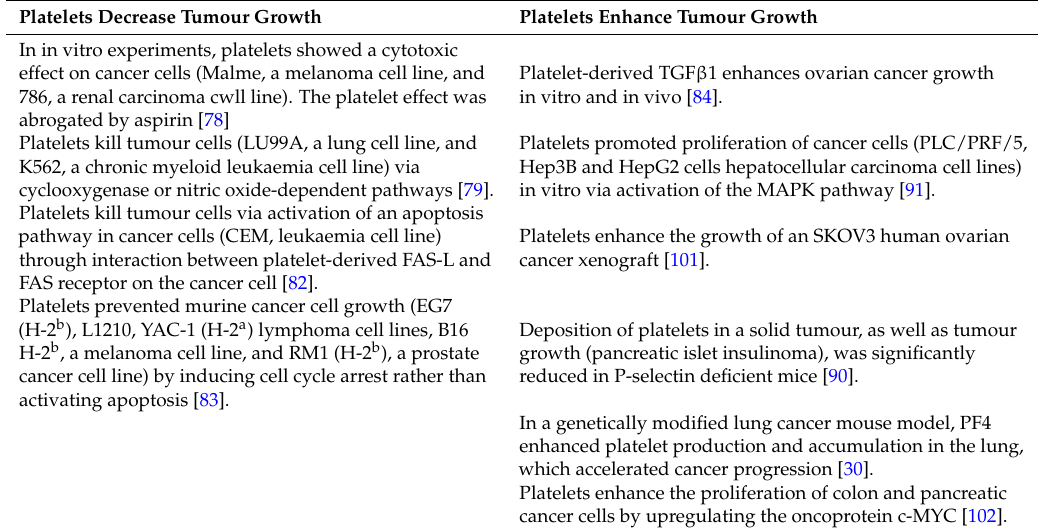
Table 3. Summary of reported platelet effects on tumour